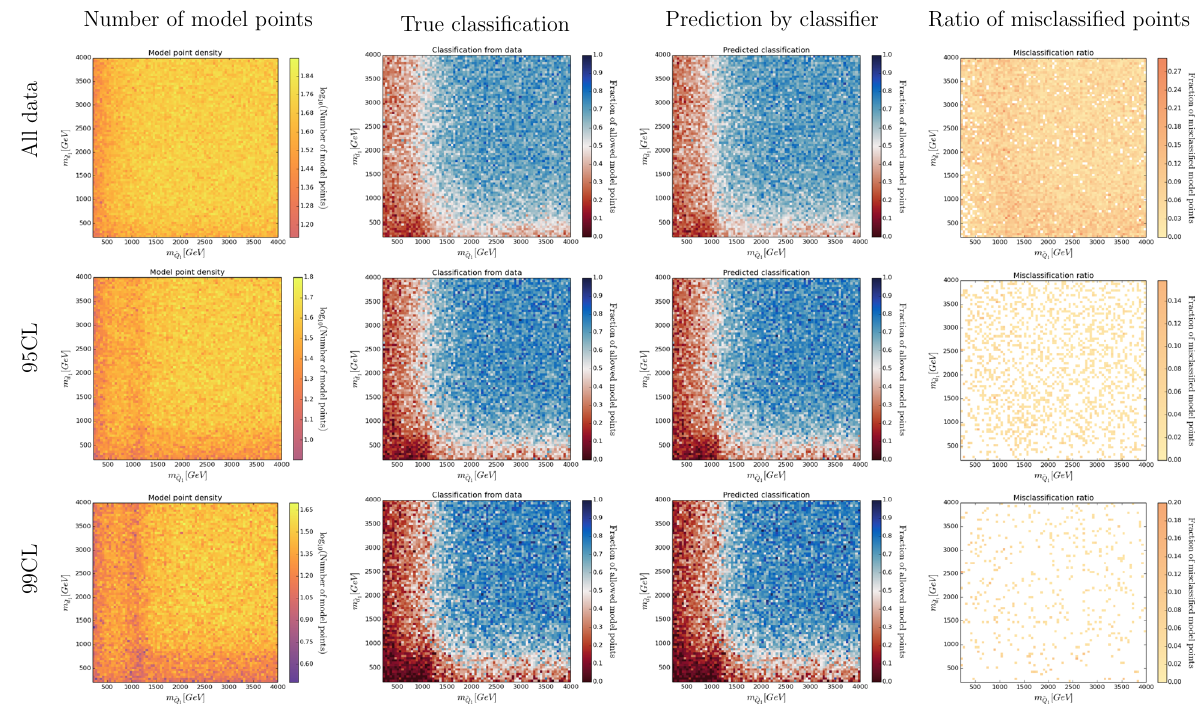
Fig. 20 Color histograms for a projection of the 19-dimensional for the true classification and the out-of-bag prediction, respectively. pMSSM parameter space on the m (cid:2) Q – m (cid:2) D plane. The color in the The last column shows the fraction of misclassified model 1 1 second and third column indicates the fraction of allowed data points